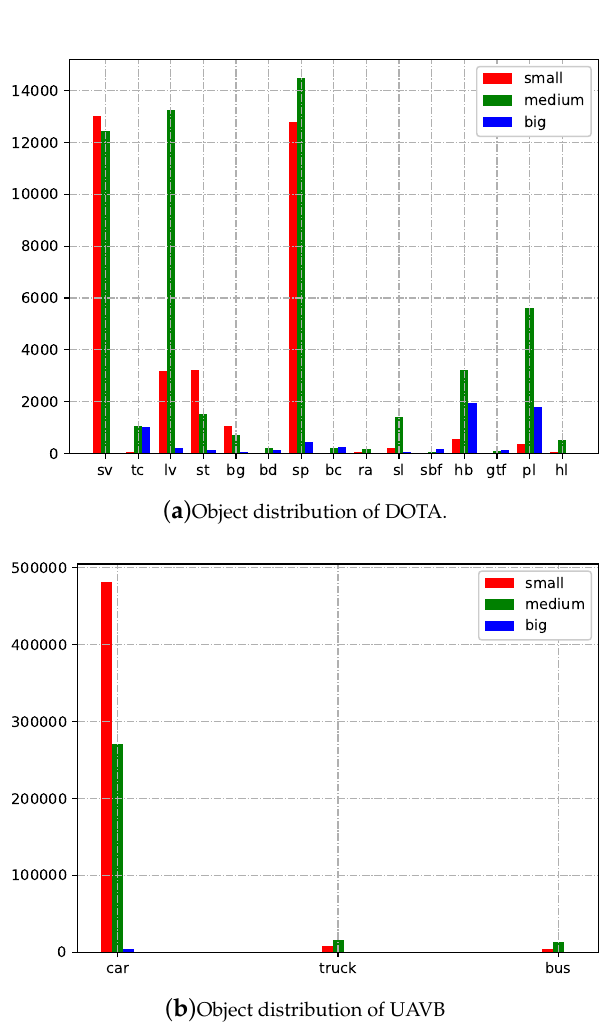
Figure 5. Objects distribution of DOTA and UAVB